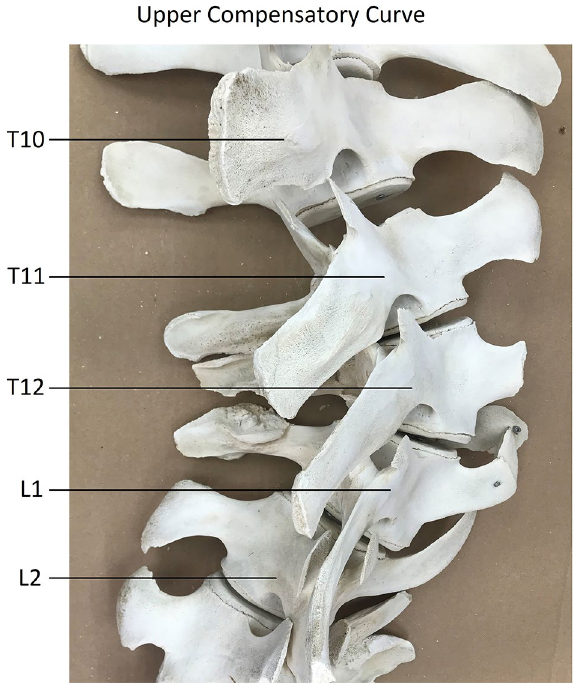
Figure 3. Close-up photograph of the apex of the upper compensatory curve, directly cranial of the post- traumatic primary curve, after removing the soft tissues. This compensatory curvature occurred in an (initially) anatomically normal part of the spine, unaffected by the